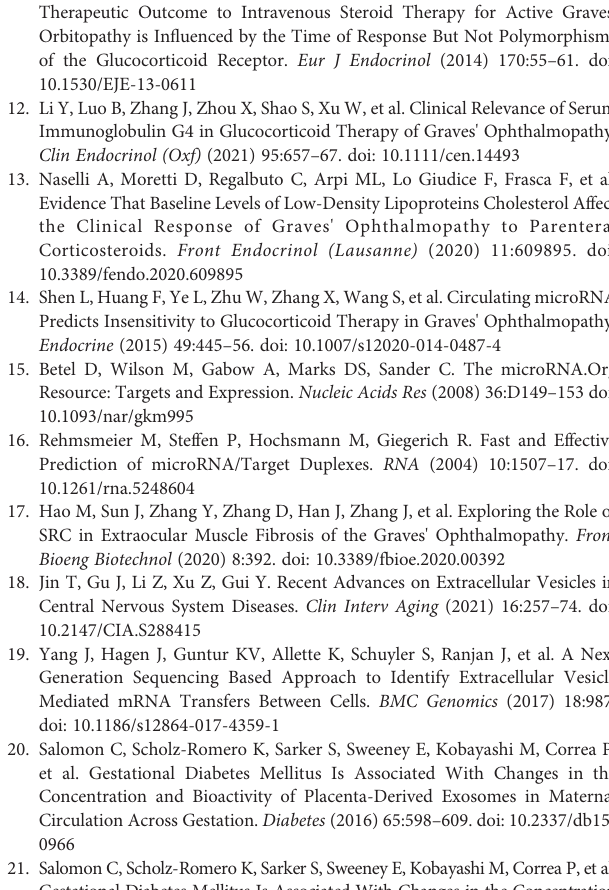
Supplementary Figure 1 | NTA analysis of plasma exosomes. Percentage: the proportion of vesicles with different